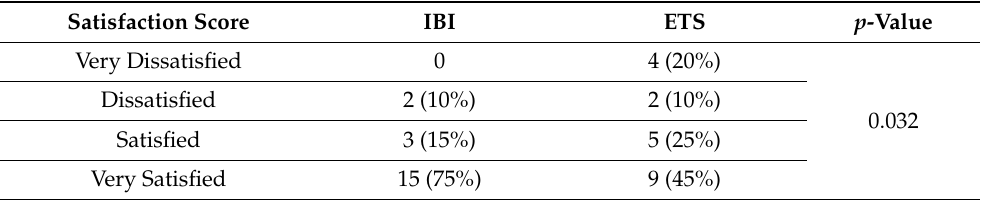
Table 5. Patients’ satisfaction by management outcome.